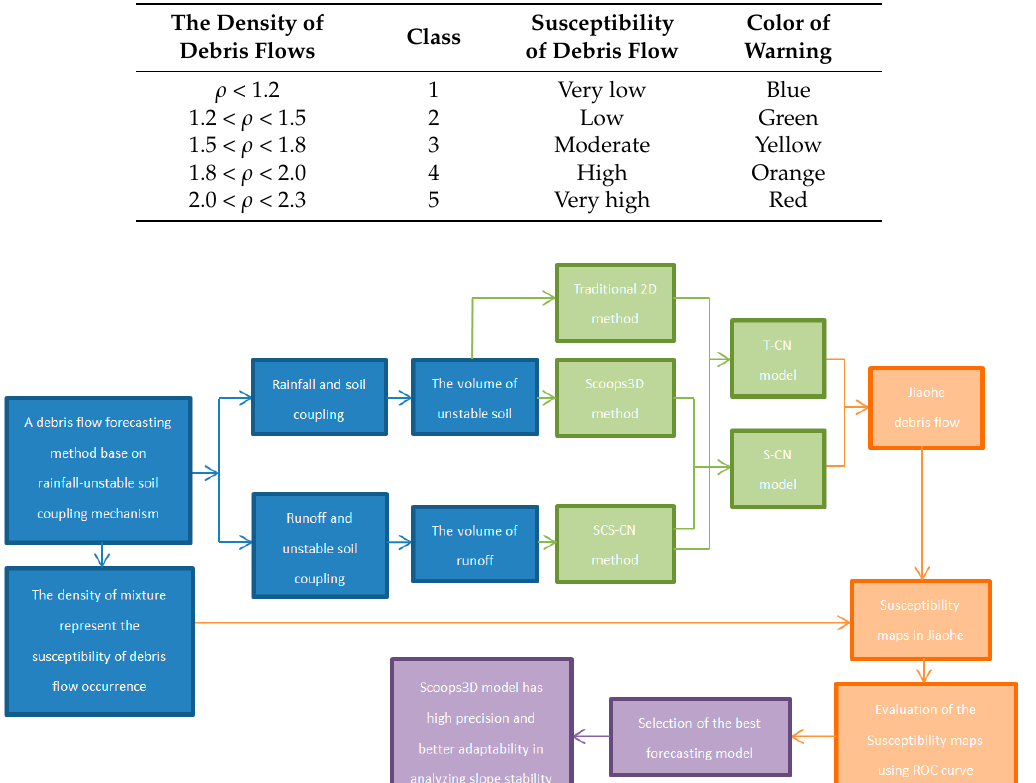
Table 1. The susceptibility of debris flow occurrence based on the water-soil mixture density. Susceptibility Color of The Density of Class of Debris Flow Warning Debris Flows ρ < 1.2 1 Very low Blue 1.2 < ρ < 1.5 2 Low Green Moderate Yellow